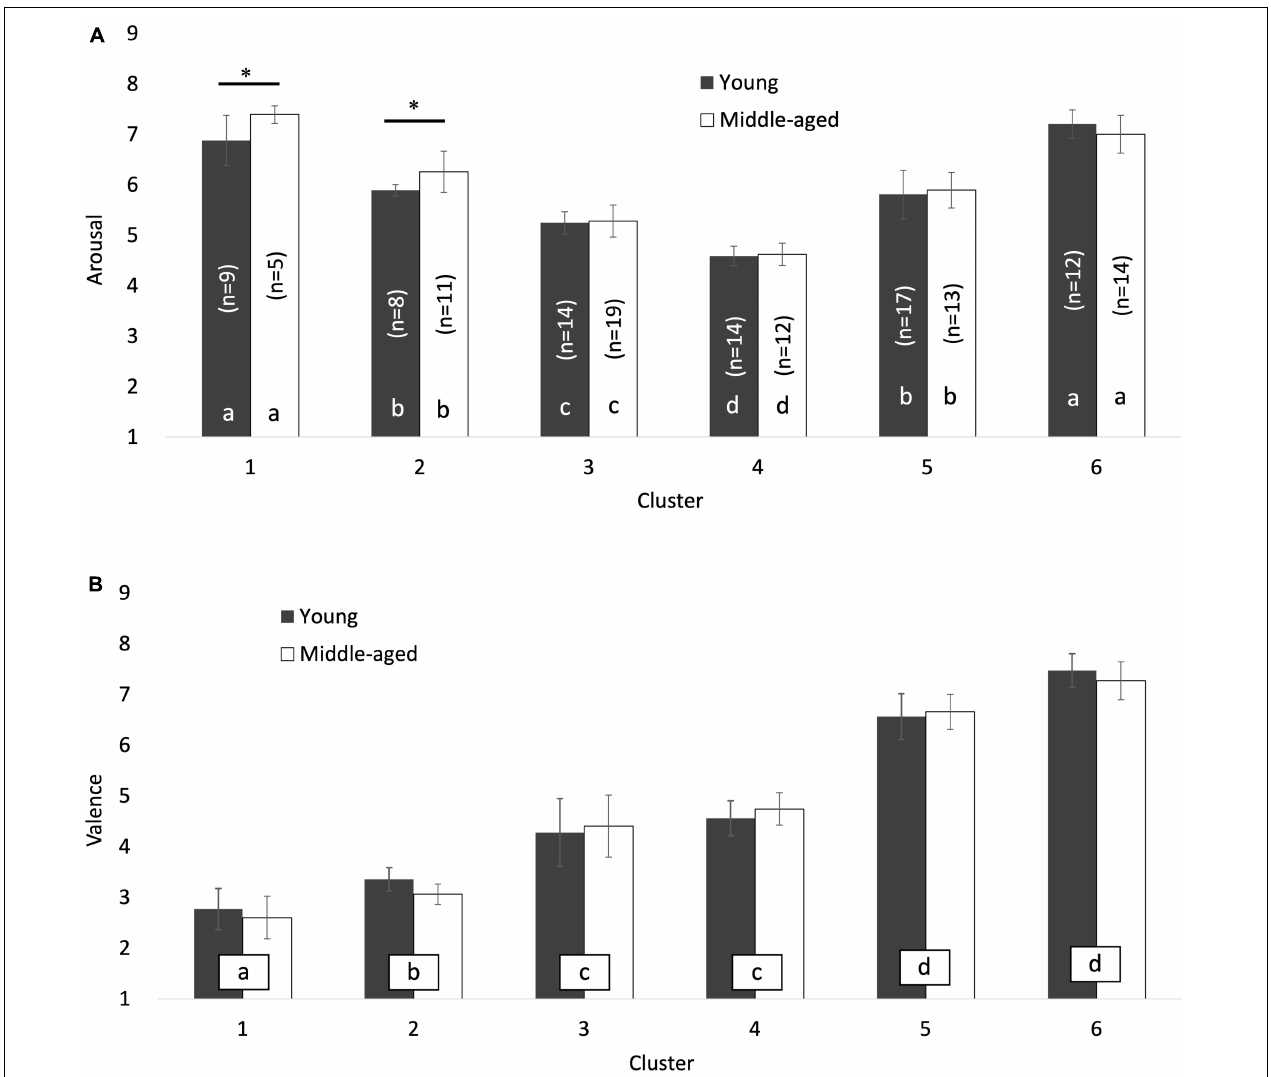
FIGURE 1 | The core affect overlaid for each cluster on the scatter plot of the mean arousal and valence scores for 74 facial emojis in (A) young people and (B) middle-aged people. The vertical and horizontal axes represent the valence and arousal levels, respectively. The error bars indicate one standard deviation for each variable (i.e., valence and arousal). Each colored circle represents the range of ± 1 standard deviation from the mean emotional valence and mean arousal for each cluster. The brackets in the bars indicate the number of emojis belonging to each cluster, which is equal in panels (A,B) . Asterisks indicate significant differences ( p <